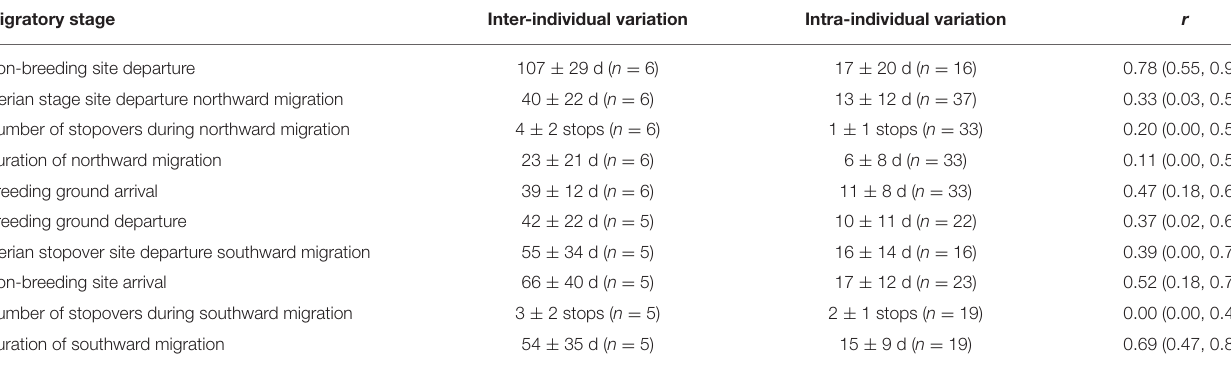
TABLE 1 | Repeatability ( r ), and inter- and intra-individual variation in migratory timing and behavior of continental black-tailed godwits tracked with satellite transmitters, GPS trackers, and solar geolocation devices, 2012–2017. Migratory stage